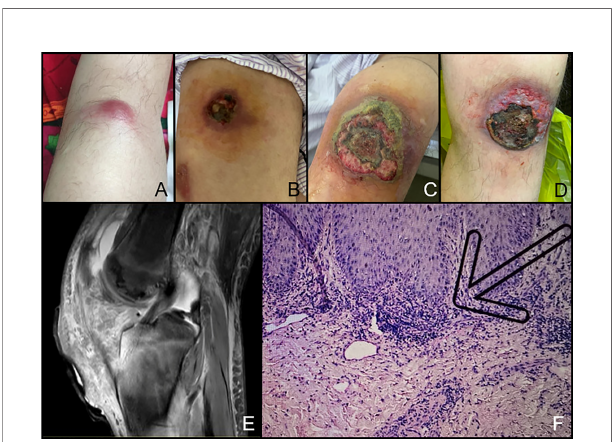
FIGURE 1 | (A) Vesiculo-pustular rashes on the trunk of this patient before treatment; (B) Rashes on the trunk of this patient after treatment; (C) Pedigree of the patient. The arrow indicates the proband. The asterisks indicate the individuals who carried c.505A > G (p. I169V) mutation in the exon 6 of the PLCG2 gene and presented with high immunoglobulin E; (D) Sanger sequencing result of the PLCG2 gene from the proband and his father; (E) Sequence alignment of PLC g 2 protein among various